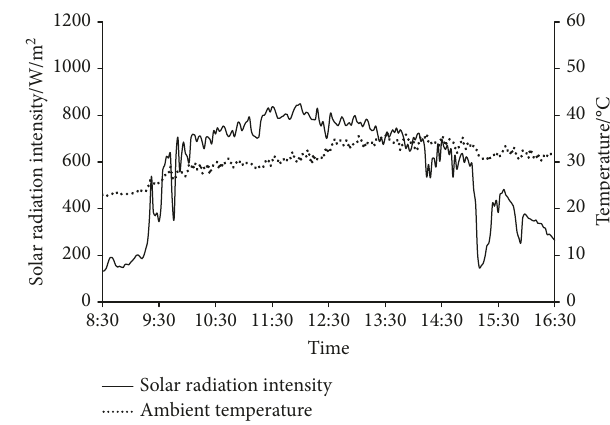
Figure 8: Solar radiation and ambient temperature.